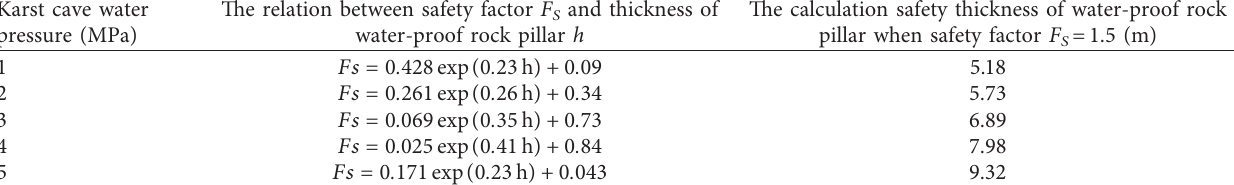
S and thickness h of the water-proof rock pillar under different karst cave water pressures.